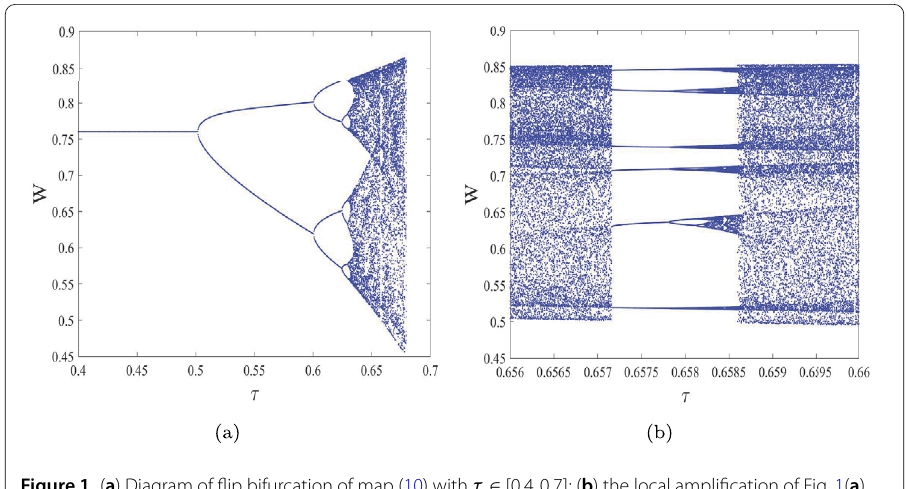
Figure 1 ( a ) Diagram of flip bifurcation of map (10) with τ ∈ [0.4,0.7]; ( b ) the local amplification of Fig. 1( a ) with τ ∈ [0.656,0.66]